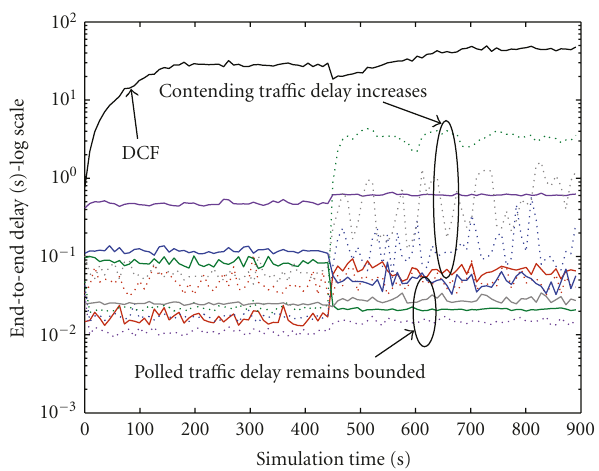
Figure 17: End-to-end delays for scenario 2.